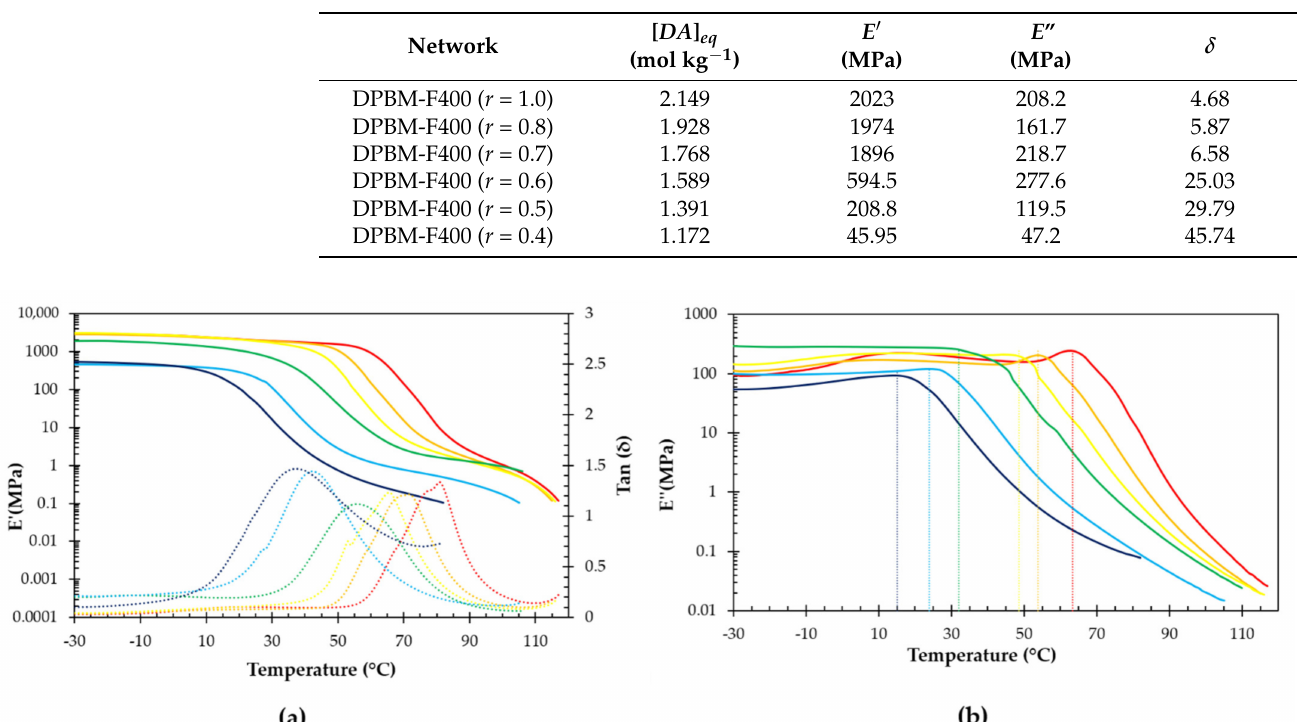
Figure 5. ( a ) Storage modulus E (cid:48) (solid lines) and Tan( δ ) (dotted lines); ( b ) Loss modulus E (cid:48)(cid:48) of DPBM-F400 with different stoichiometric ratio: r = 1 (red), r = 0.8 (orange), r = 0.7 (yellow), r = 0.6 (green), r = 0.5 (light blue), and r = 0.4 (dark blue), measured at 1 Hz and 0.1%